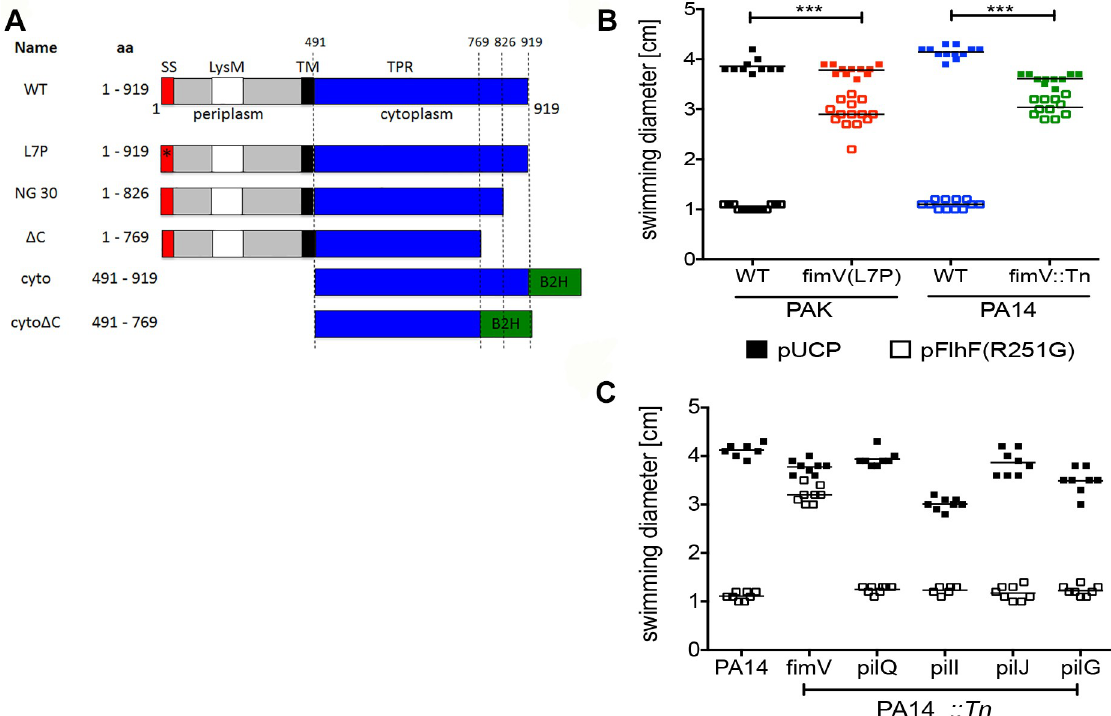
Fig 3. FimV(L7P) is a suppressor of FlhF(R251G). (A) FimV constructs . The predicted signal sequence (SS, red), LysM domain (white), periplasmic region (grey), transmembrane helix (TM, black) and tetratricopeptide repeats (TPR) (blue) are diagrammed. ω or Zif fusions for bacterial 2-hybrid screen are also shown (B2H, green). (B) Loss of FimV function suppresses FlhF(R251G) . Swimming zone diameters of PAK (black), PAK fimV(L7P) (red), PA14 (blue) and PA14 fimV :: Tn (green) harboring either pUCP (vector control (VC)) or pFlhF(R251G) (open) are shown; each symbol is a biological replicate (line indicates mean). Disruption of fimV significantly alters swimming behavior of FlhF(R251G)-overexpressing bacteria ( ��� , p < 0.001; 2 way ANOVA followed by Bonferroni posttest). (C) Pil/Chp system mutants associated with low intracellular [cAMP] do not suppress FlhF(R251G) . Wild-type and transposon mutant bacteria harboring either empty vector (pUCP; solid) or pFlhF(R251G) (open) were assayed for swimming motility. Each symbol is a biological replicate; line indicates mean. Only disruption of fimV suppresses the dominant-negative phenotype associated with FlhF(R251G) overexpression ( ��� , p < 0.001; 2 way ANOVA with Bonferroni posttest).